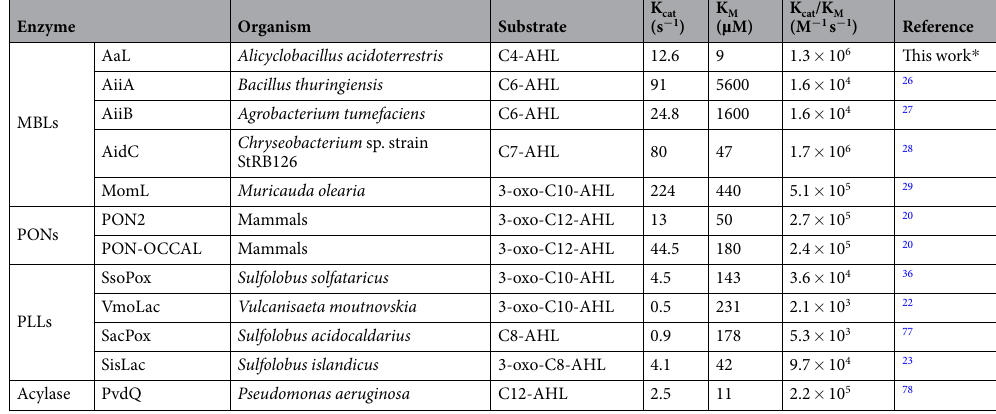
Table 1. Kinetics parameters for several quorum quenching enzyme representatives. * The kinetics were performed in activity buffer (2.5 mM Bicine pH 8.3, 150 mM NaCl, 0.2 mM cresol purple, 0.5 % DMSO and with 0.2 mM CoCl 2